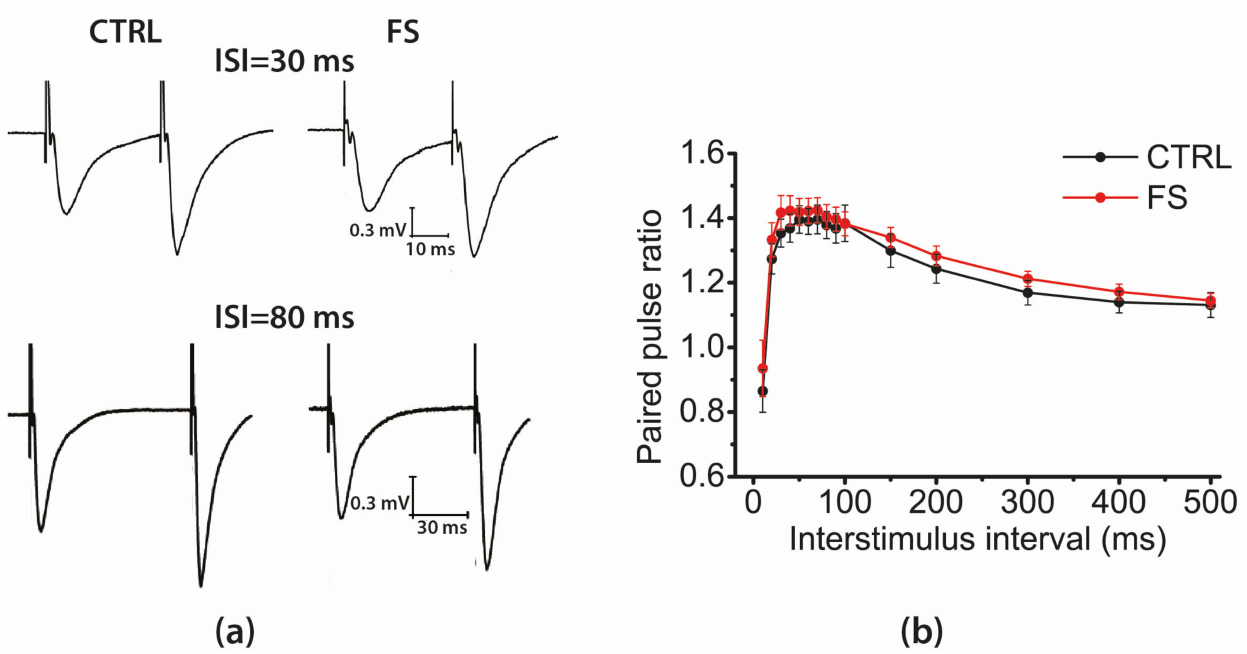
Figure 3. Short-term synaptic plasticity did not change in rat hippocampal slices after FS. ( a ) Representative examples of pair-pulse responses from the hippocampal CA1 area in control (CTRL) and post-FS rats (FS), interpulse intervals of 30 ms and 80 ms. ( b ) Diagram showing the paired-pulse facilitation in hippocampal slices across different inter-stimuli. Each point represents the mean ±